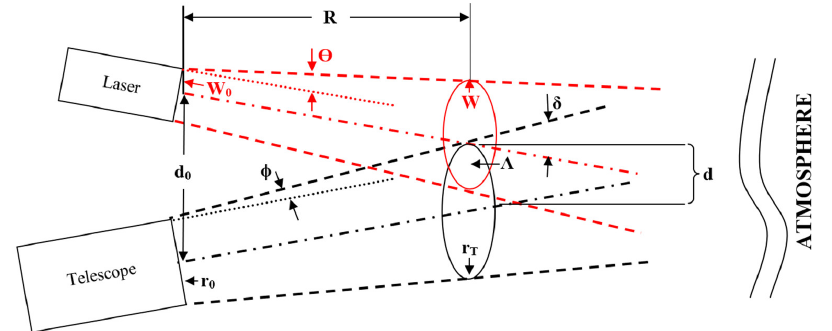
Figure 1. Biaxial scheme of lidar, which shows the condition for partial overlap between the telescope field-of-view and a laser beam (r 0 is the telescope radius; W 0 is the laser beam radius; d 0 is the distance between the laser beam and telescope centers; θ is the radiation divergence half-angle; r T is radius of the field of view of the optical receiving system in the plane of the object under study; W is radius of the laser pulse in the plane of the object under study; d is distance on the plane of the object under study between the points of intersection with the plane of the laser and telescope axes; and φ is half the divergence angle of the optical receiving